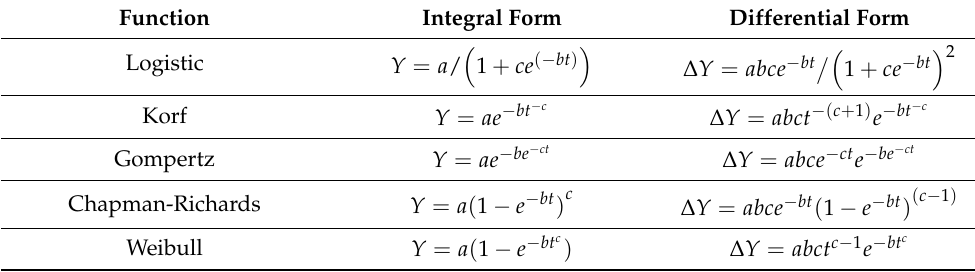
Table 2. Growth functions of integral and differential form used in this study. Function Integral Form Differential Form